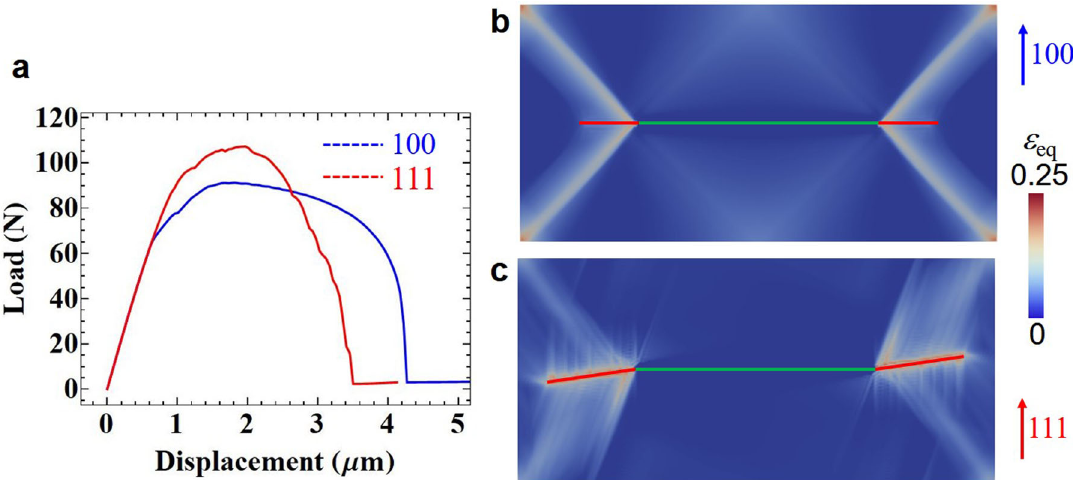
Fig. 3 Crack growth in (100)- and (111)-oriented single crystals. a Load-displacement curves with the load applied to (100)- and (111)- oriented single crystals. b , c Distribution of equivalent plastic strain in (100)- and (111)-oriented single crystals, respectively. The red lines indicate the newly grown cracks and the green lines represent the initial